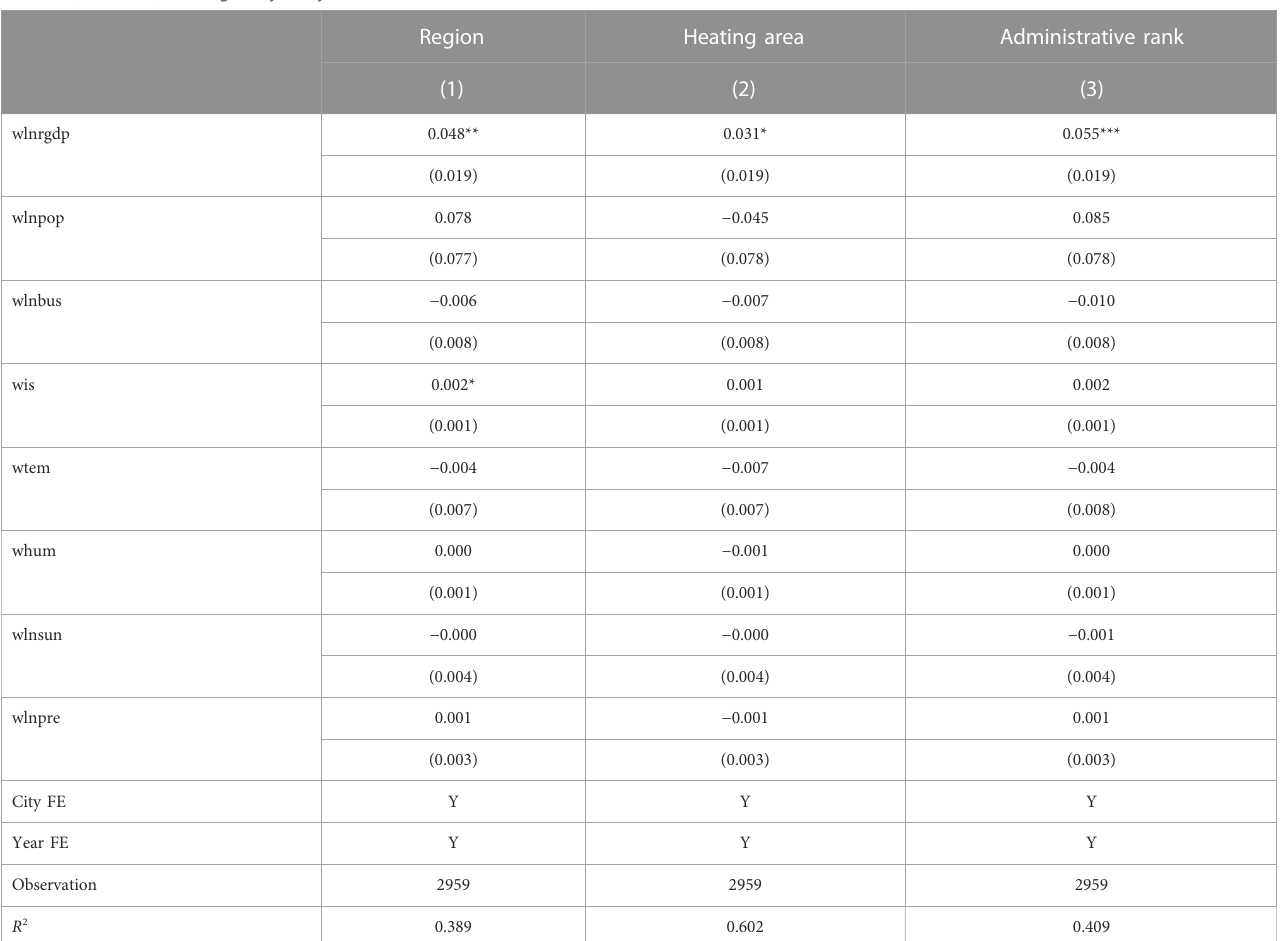
According to the results in Table 7, the regression coef fi cient of AAQS×Central in column (1) is 0.023, which passes the 1% signi fi cance level test. The effect of AAQS on air pollution in the central region is signi fi cantly lower than that in the eastern region, with a reduction effect of only 0.1%. The regression coef fi cient of AAQS×Western is − 0.009, which does not pass the 10% signi fi cance level test, indicating that there is no signi fi cant difference between the effects of AAQS on air pollution in the eastern and western regions. The coef fi cient of AAQS×Heating in column (2) is 0.035, which passes the 1% signi fi cance level test. This indicates that AAQS can signi fi cantly reduce PM 2.5 concentration in non-heating areas